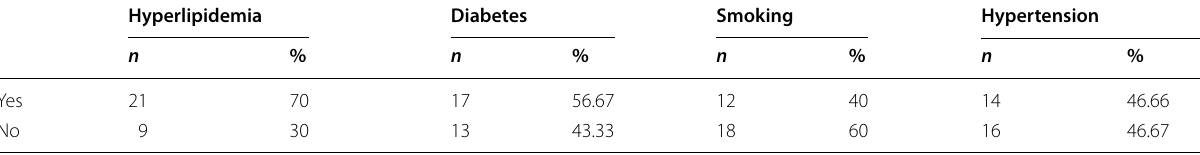
Table 2 Vascular risk factors among studied patients